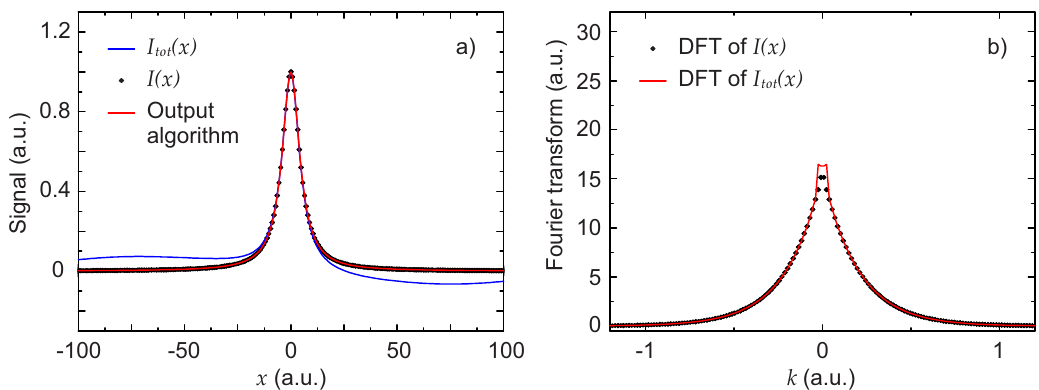
Figure 5. Second scenario: weak disturbance with an FSR as large as the measuring window. ( a ) simulated experimental total signal I tot ( x ) (blue line), Lorentzian line shape signal I ( x ) (black dots) and extracted signal obtained with the algorithm (red line); ( b ) DFT of the total signal | F ( I tot ( x ))( k ) | (red line) and DFT of the Lorentzian signal | F ( I ( x ))( k ) | (black